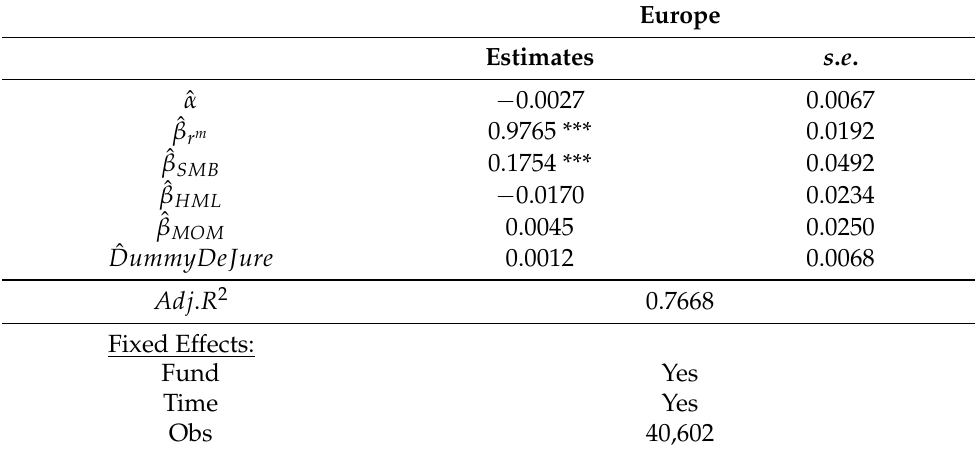
Table A1. Estimation of the panel version of Carhart’s model (2013–2018) with